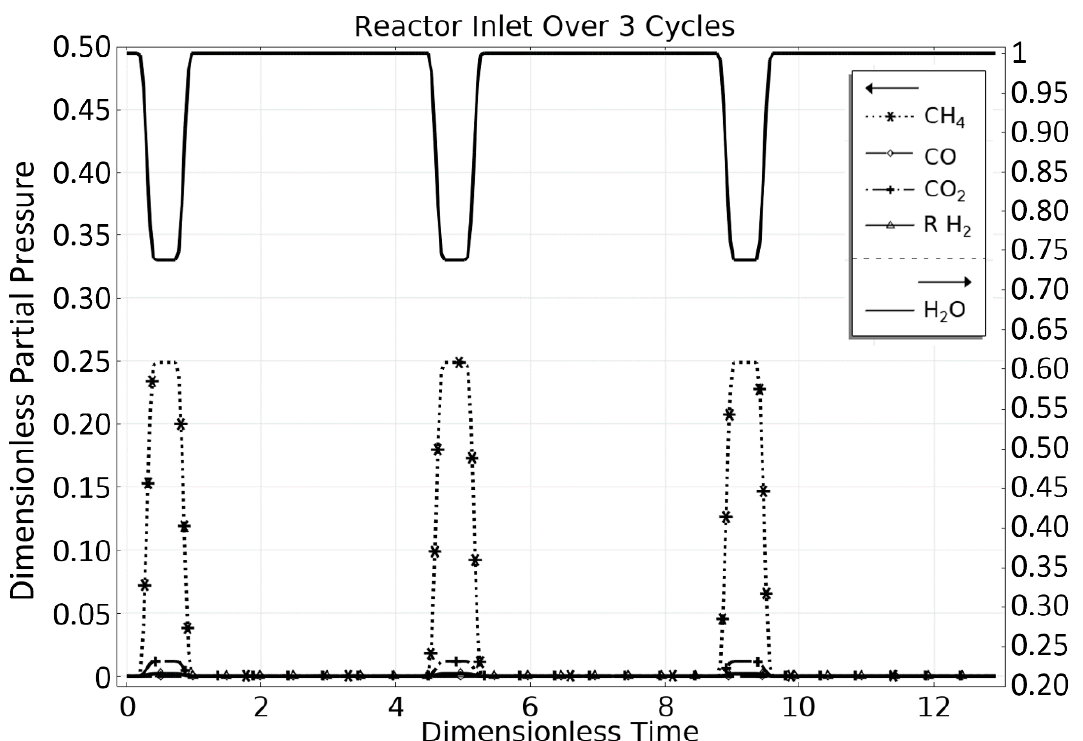
Figure 3. Dimensionless time evolution of species’ dimensionless partial pressure at reactor inlet over 3 cycles of operation for Da = 2, Θ = 10.